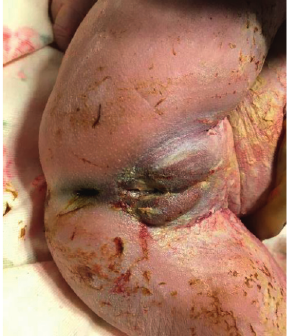
Figure 5: No perineal abnormalities (anus and perineum are normal) in a neonate with alobar